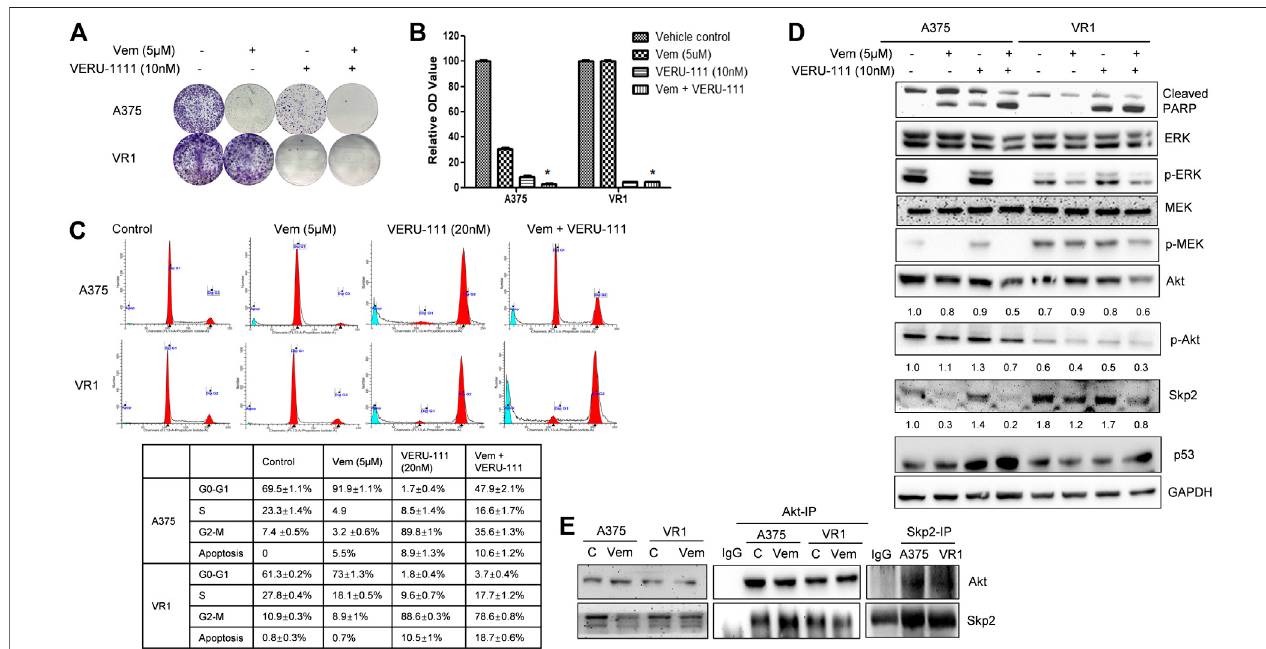
FIGURE2| Combinationtreatment ofVemand VERU-111sensitizesbothA375and VR1cells (A) Colonyformationassay.1,000Cellswereseededinthe12-well platesandtreatedwithindicatedconcentrationofdrugs,after8 days,stainedwithcrystalviolet (B) Quanti fi cationofclone formationassay.Colonieswerelyzedinbuffer with SDS, then read the absorbance at 490 nm *, p < 0.05, compared with single-agent treatment groups (C) Cell cycle distribution and apoptosis of combination of vemurafenib and VERU-111 in A375 and VR1 cells. Data was analyzed with Mod fi t 2.0 software, and apoptosis cells were counted automatically (D) Signaling pathwayinbothA375andVR1cellsaftercorrespondingtreatment (E) BothA375andVR1cellweretreatedwithDMSOand5uMVem,andthenperformedendogenous Co-IP between AKT and